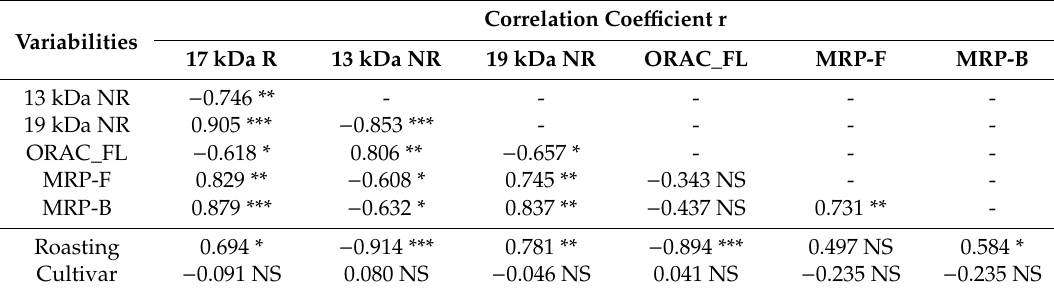
Table 4. The relations between the selected variables, the roasting conditions and cultivar.